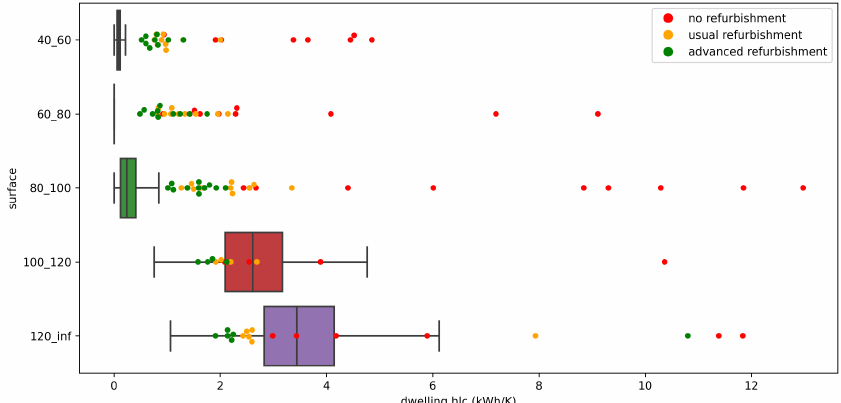
Figure 17. hlc comparisons between TABULA average buildings and inferred values (surfaces model).